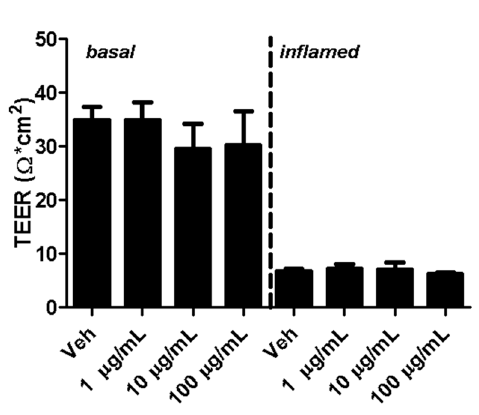
Figure 4. Transendothelial electrical resistance (TEER) of mouse brain microvascular endothelial cell (MBMEC) cultures. TEER values of MBMECs 18 h after exposure to I + T (100 IU each; inflamed) and treatment with fullerenols (1, 10 and 100 µg/mL; n = 3) compared to cultures under basal conditions. Veh, vehicle treatment.